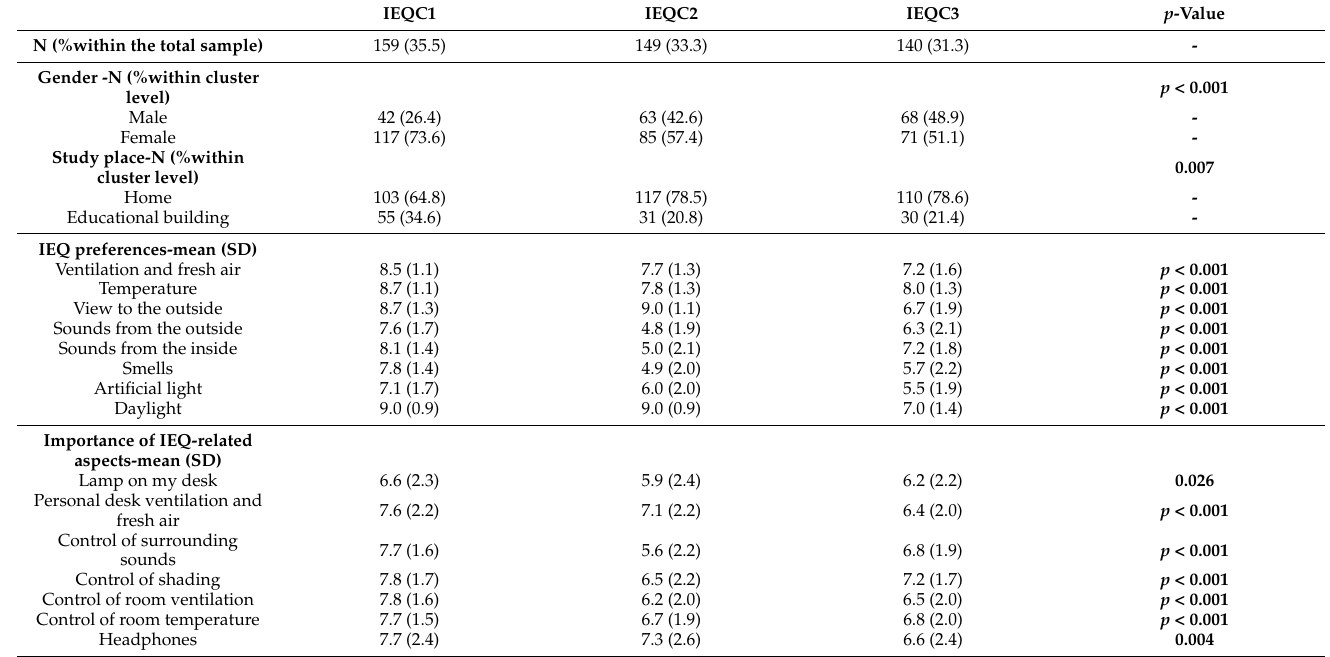
Table 3. Descriptives of IEQ